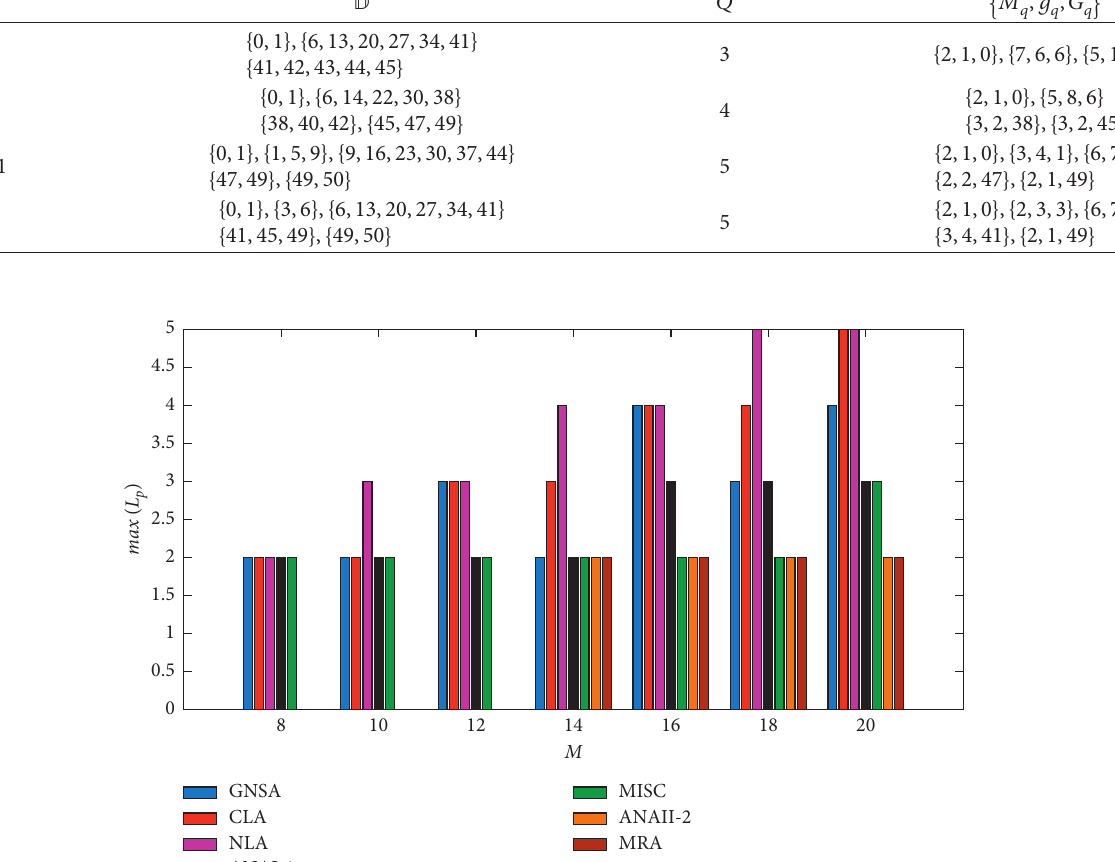
Figure 2: max ( L ) in different sparse arrays with different M . p